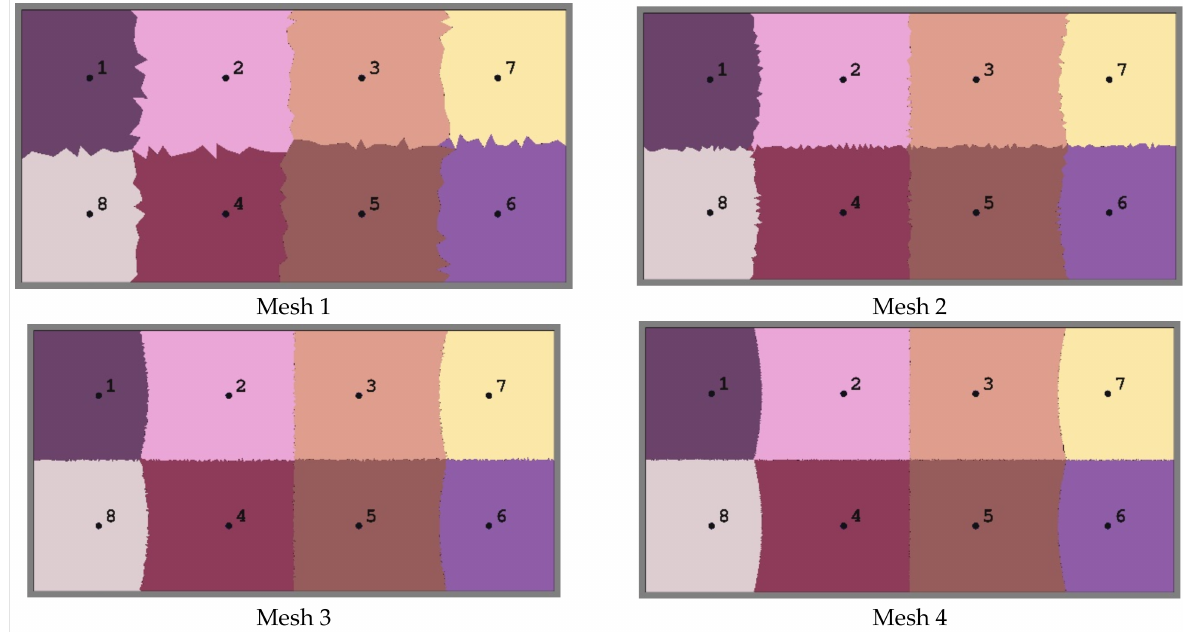
Figure 5. Smoothness of consumer areas with mesh refinement. Dots denote locations of stores of 8 different